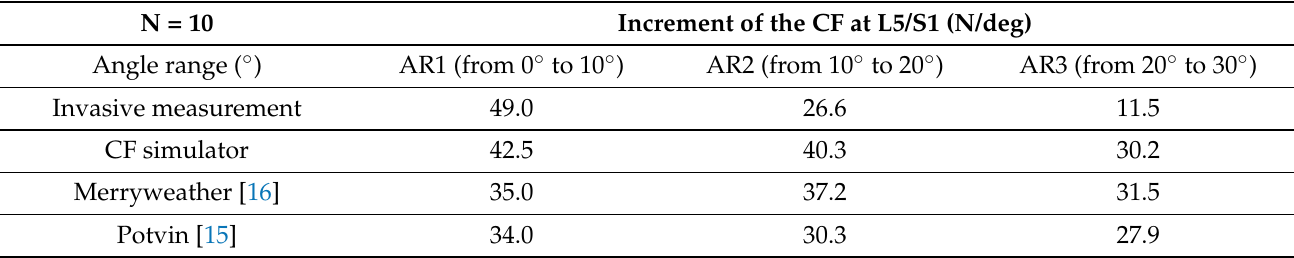
Table 3. Relationship between compressive force (CF) and flexion angle estimated with different models and measurements. N = 10 Increment of the CF at L5/S1 (N/deg) Angle range ( ◦ ) Invasive